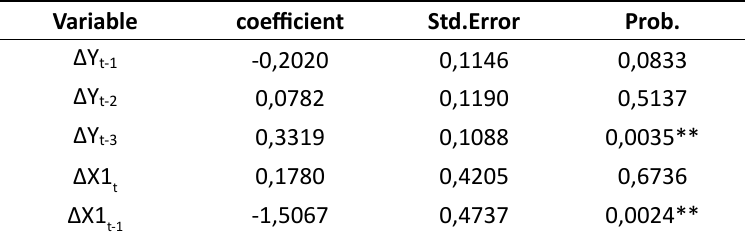
Table 7: Short Term Estimation